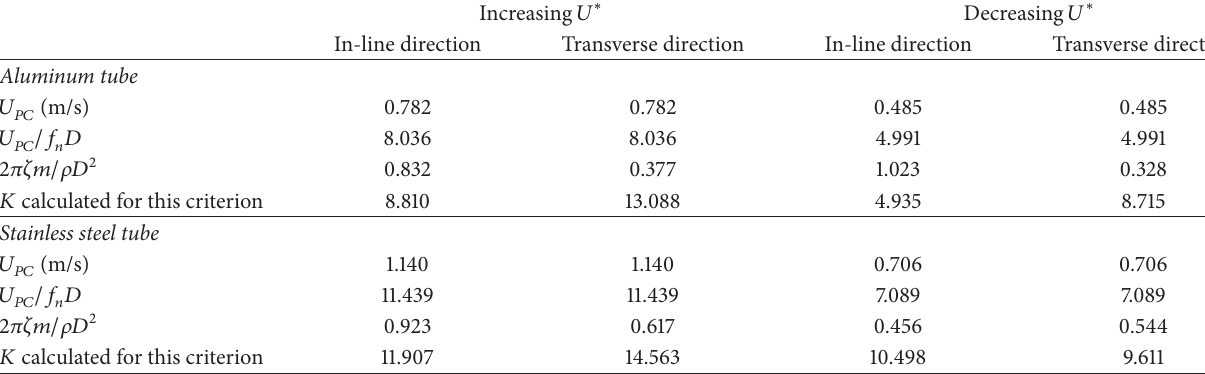
Table 2: Summary of fluid-elastic instability